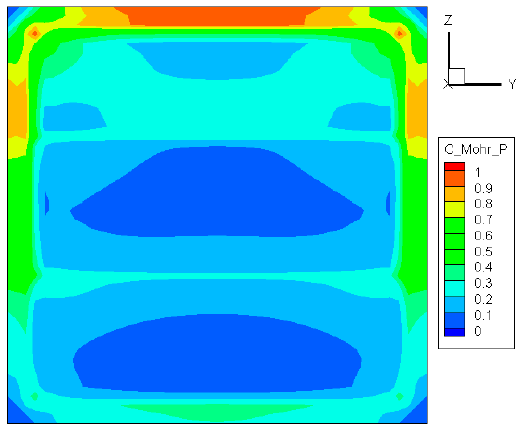
Figure 8. Distribution of σ vm /0.577 S ut before crack initiation.